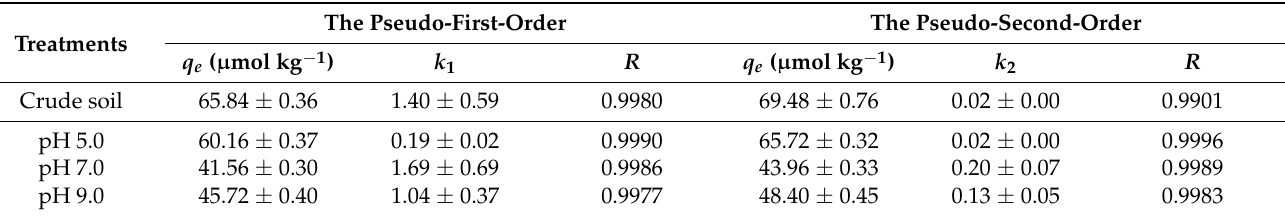
Table 2. Fitting results of kinetics data to pseudo-first and pseudo-second-order equations for SDZ adsorption in various soil solutions (mean values ± standard error). The Pseudo-First-Order The Pseudo-Second-Order Treatments Crude